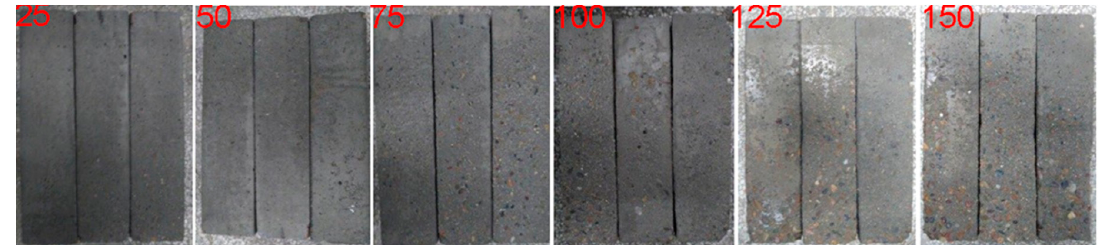
Figure 1. Concrete specimens with the different number of freezing–thawing cycles.